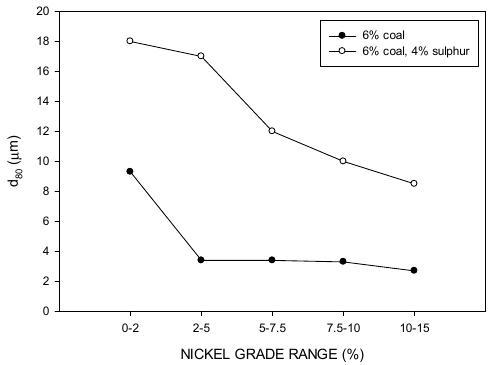
Figure 15. Effect of nickel grade range on the cumulative 80% passing size (d 80 ) as a function of the nickel grade range for the sample containing 6% coal and the sample containing 6% coal plus 4% sulphur.